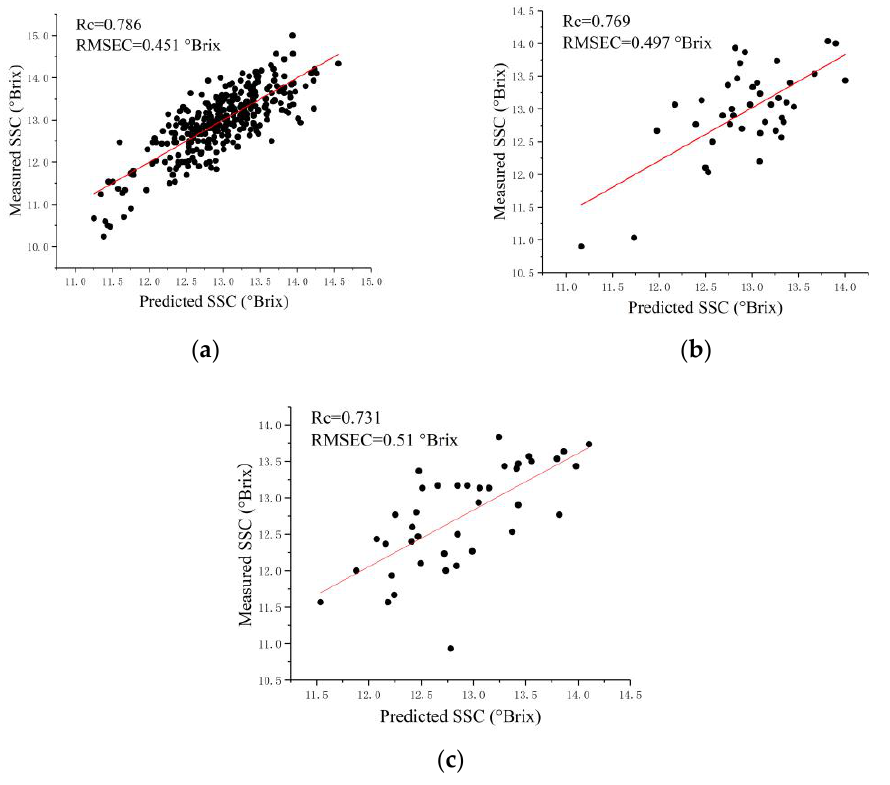
Figure 3. Scatter plots of the measured SSC values and predicted SSC values by SVR. ( a ) FX10-SP-A of calibration set; ( b ) FX10-SP-A of validation set; ( c ) FX10-SP-A of prediction set.